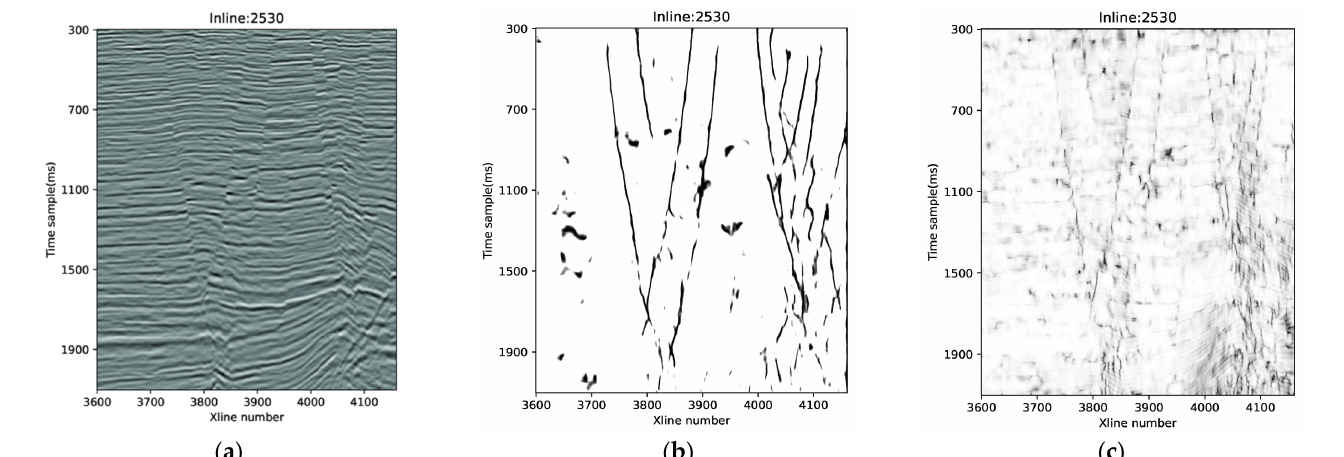
Figure 12. ( a ) A seismic image is displayed with faults that are detected using ( b ) the trained FCN model and ( c ) fault likelihood.